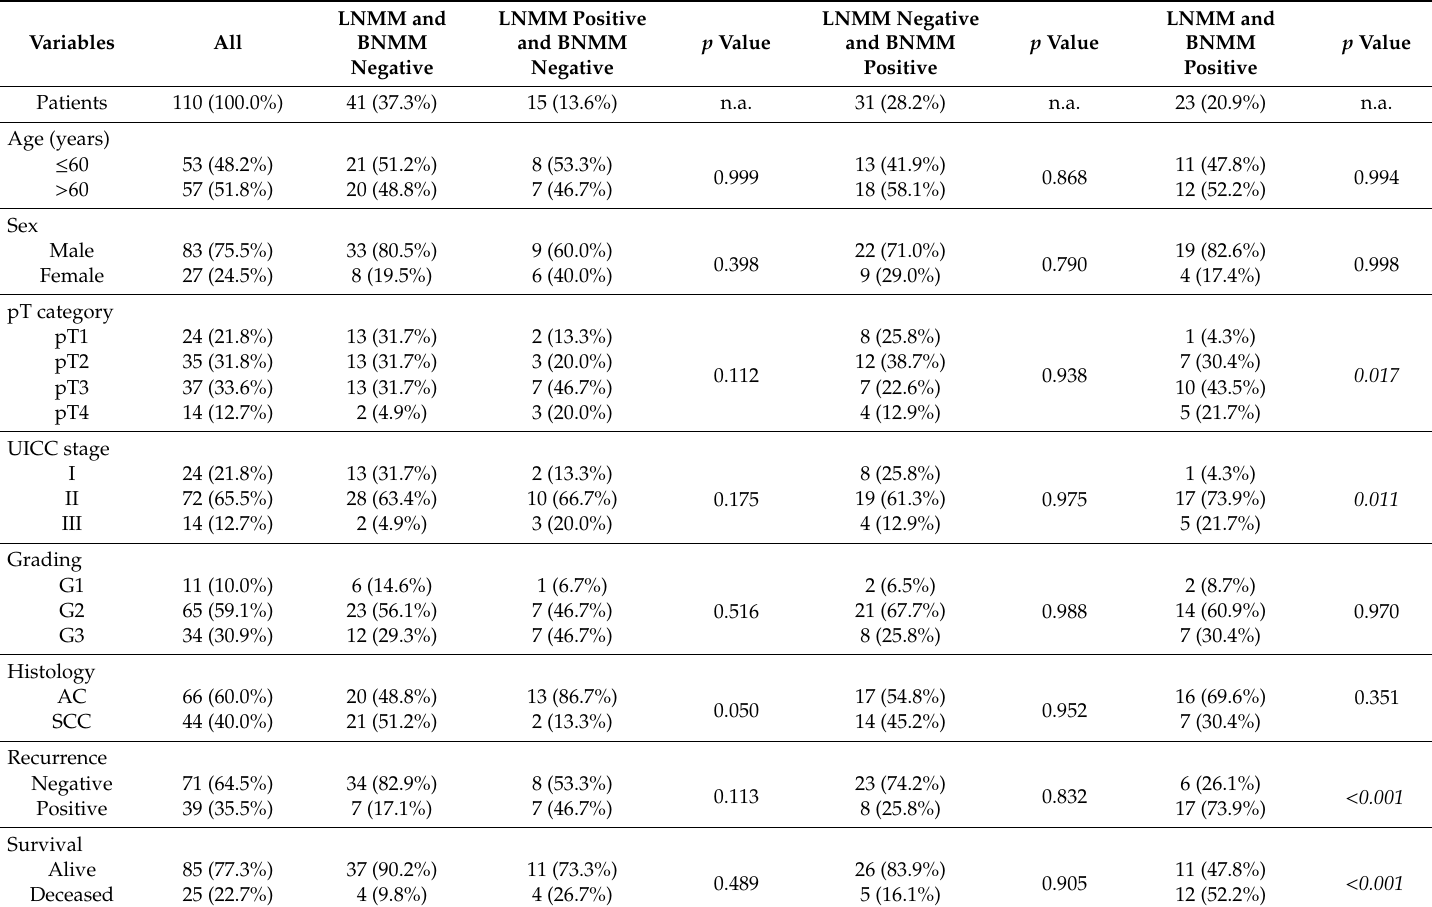
Table 1. Comparison of the lymph node / bone marrow micrometastases status with patients’ clinicopathological